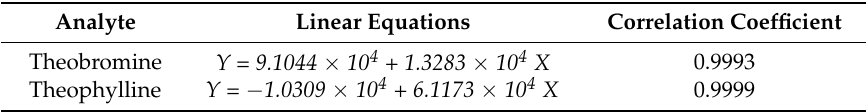
Table 1. The standard curve equations of theobromine and theophylline.